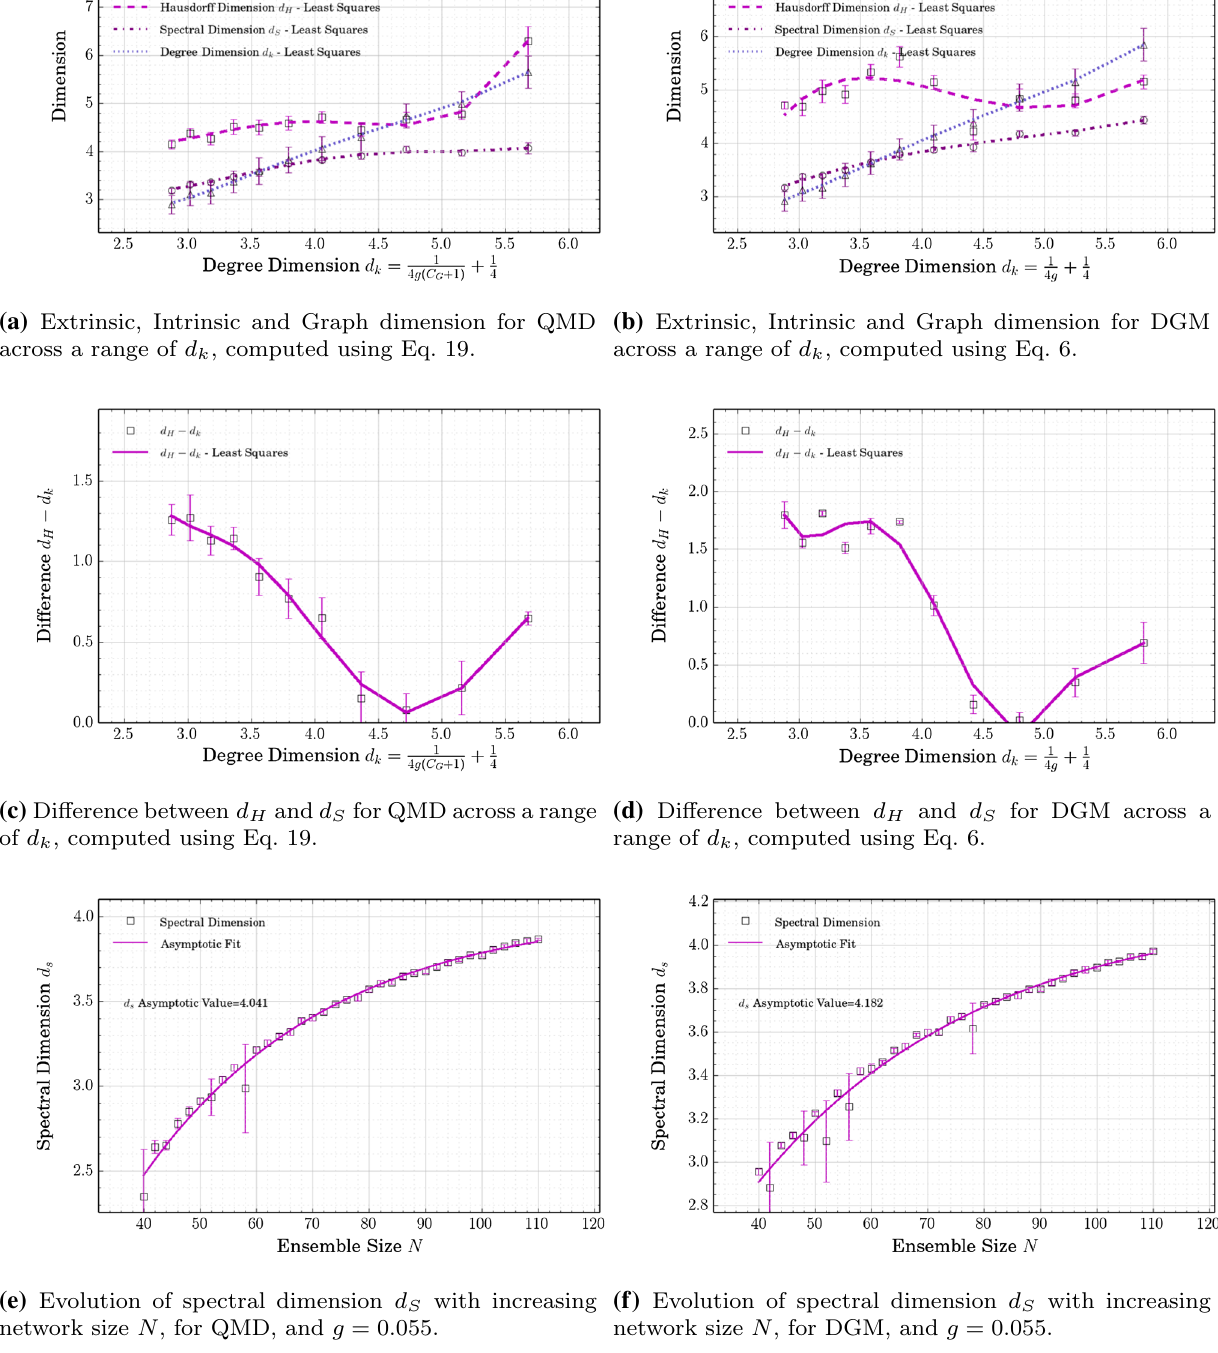
Fig. 5 Dimensional analysis of the graphs obtained as the ground state of QMD and DGM. Displayed are the three measures of dimensionality against graph dimension, the divergence of the extrinsic and graph measures and the evolution of spectral dimension with